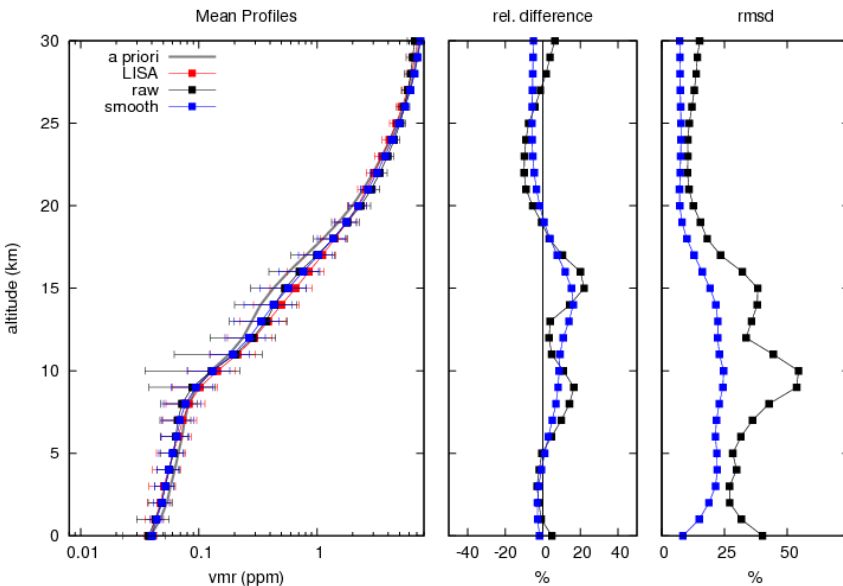
Fig. 5. Same as Fig. 3 for the LISA Figure 5. same as Fig. 3 for the LISA product.